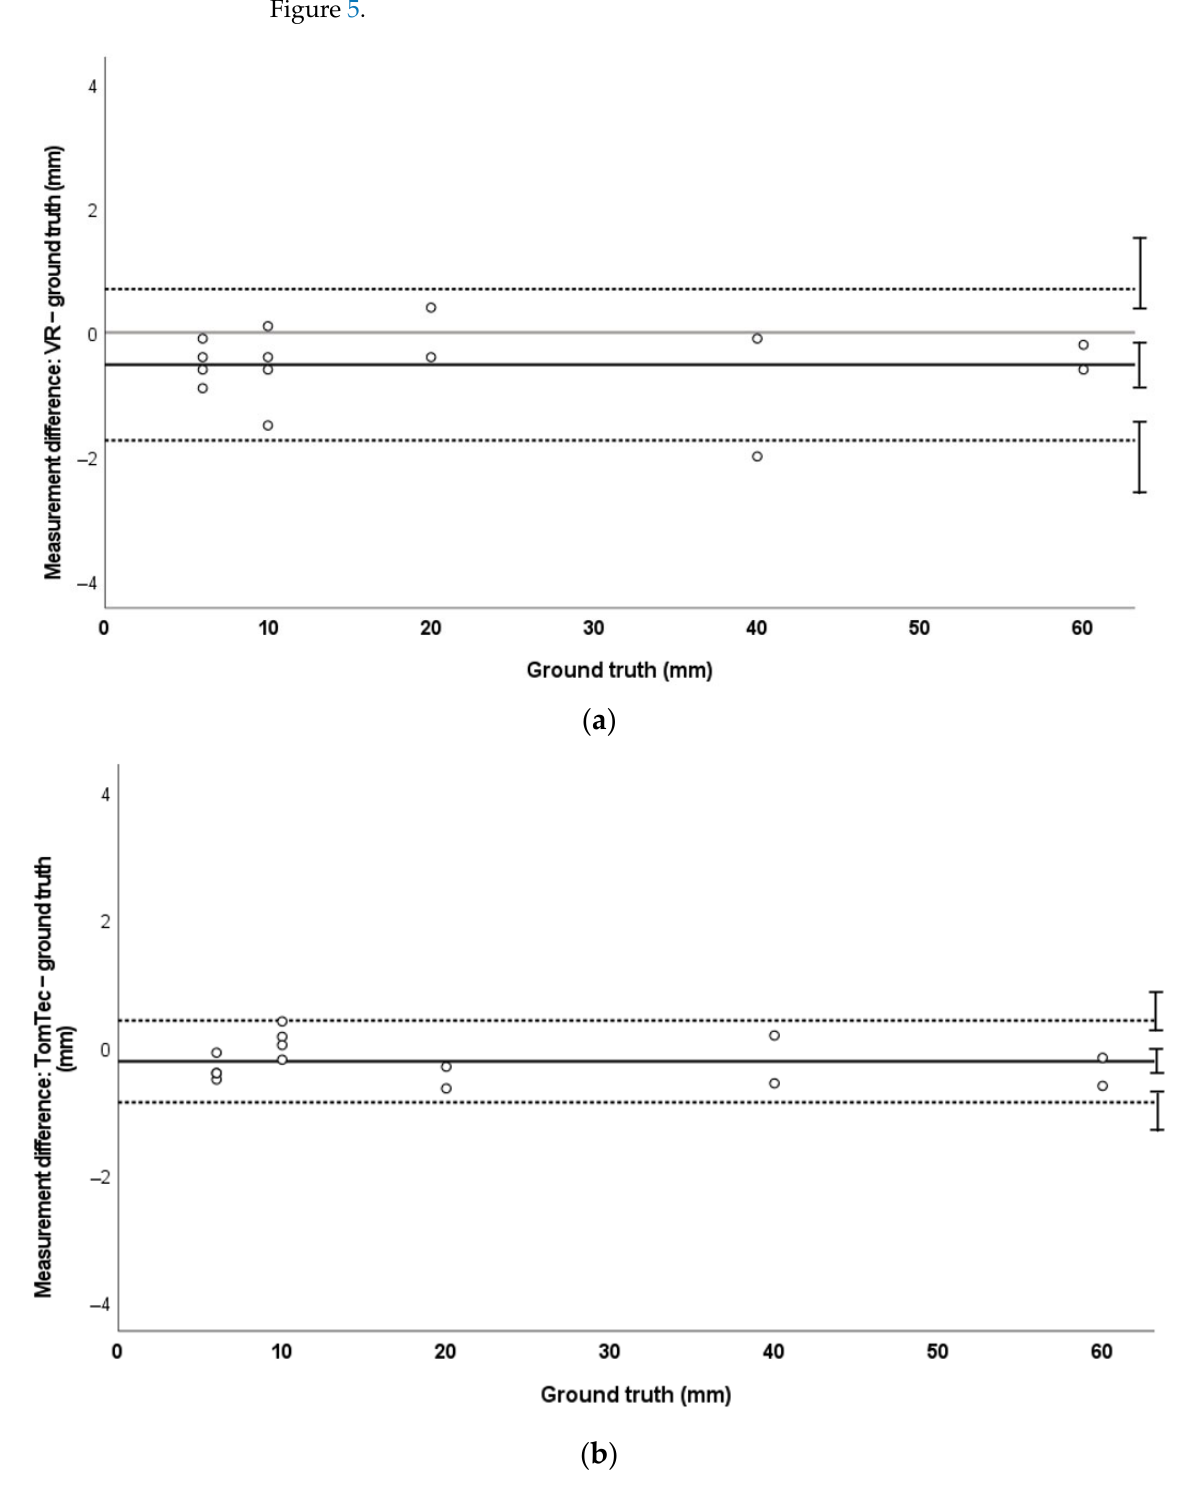
Figure 5. Bland–Altman plots demonstrating measurement agreement for 3D echocardiographic measurements against ground truth in VR ( a ) and TomTec ( b ).